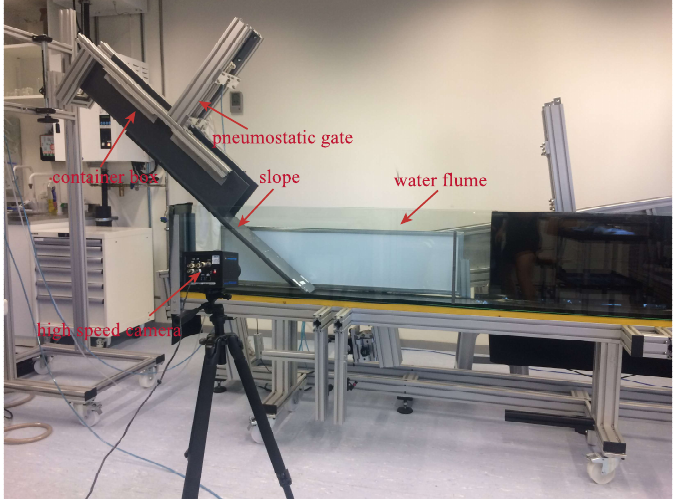
Figure 2. The experimental